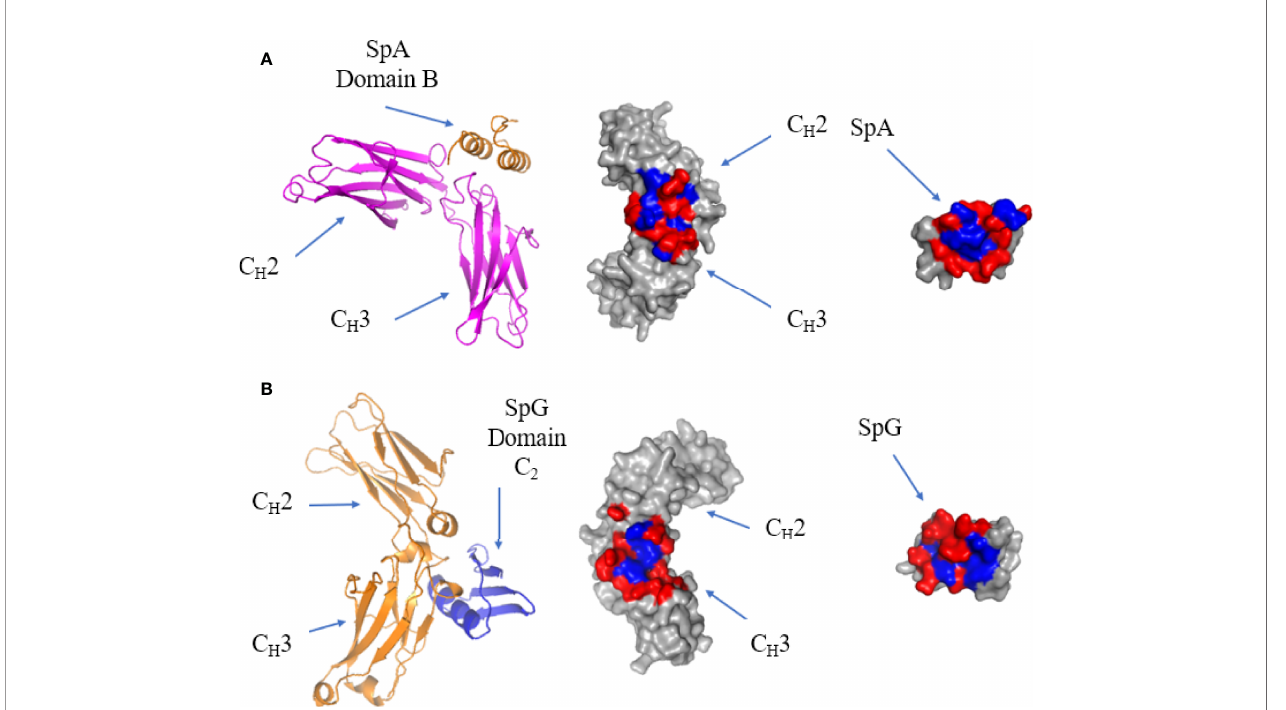
FIGURE 8 | Binding of SpA and SpG superantigens to -IgG Fc. (A) Left panel: ribbon plot of SpA Domain B (Orange) bound to IgG Fc (Pink) at the C H 2-C H 3 interface (PDB code: 5U4Y). Middle panel: IgG Fc showing polar (red) and hydrophobic residues (blue). Right panel: SpA. (B) Left panel: ribbon plot of SpG Domain C2 (Blue) bound to IgG Fc (Orange) at the C H 2-C H 3 interface (PDB code: 1FCC). Middle panel: IgG Fc. Right panel: